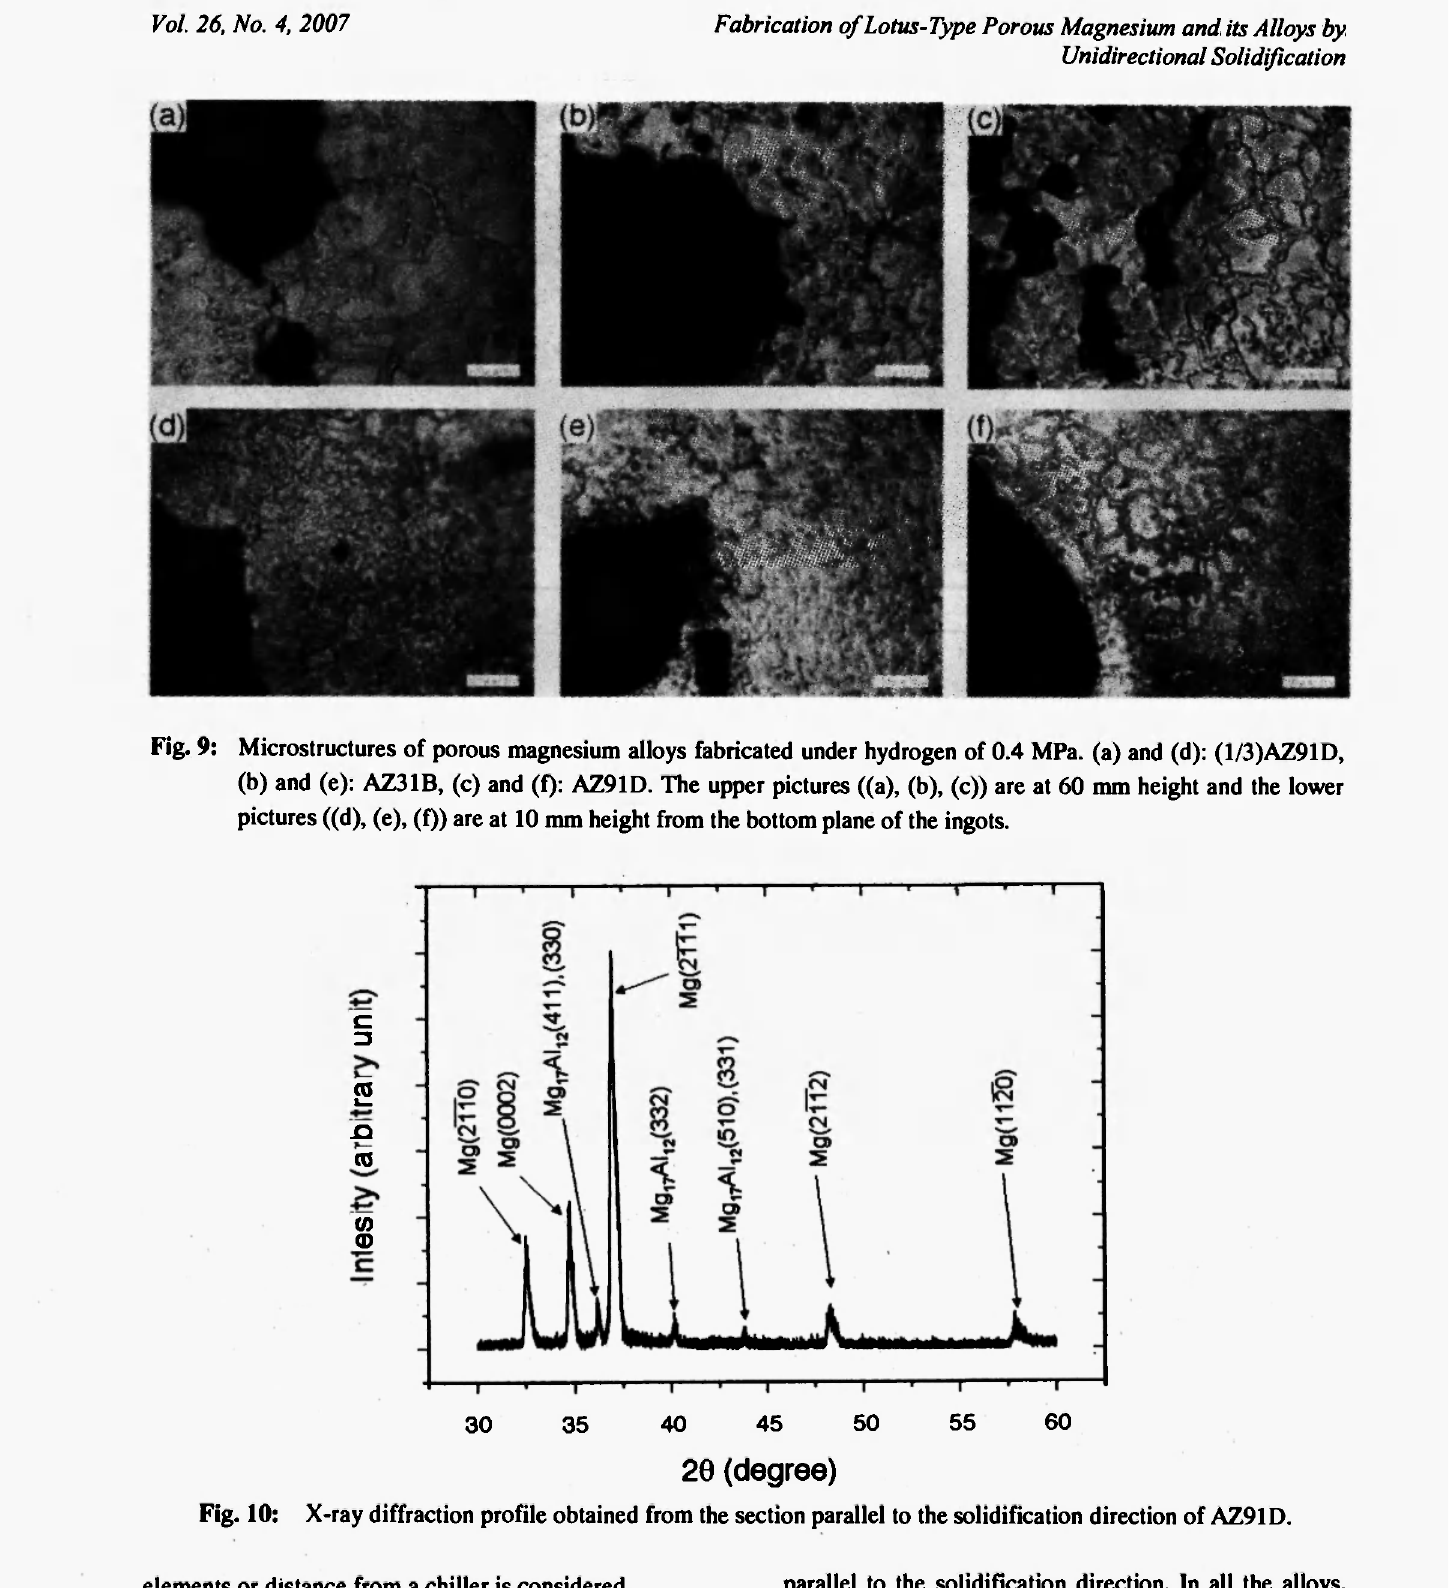
Fig. 10: X-ray diffraction profile obtained from the section parallel to the solidification direction of AZ91D. elements or distance from a chiller is